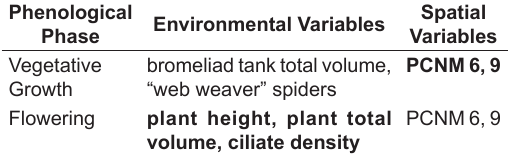
Figure 4. Distances to centroid in vegetative growth and flowering phases.